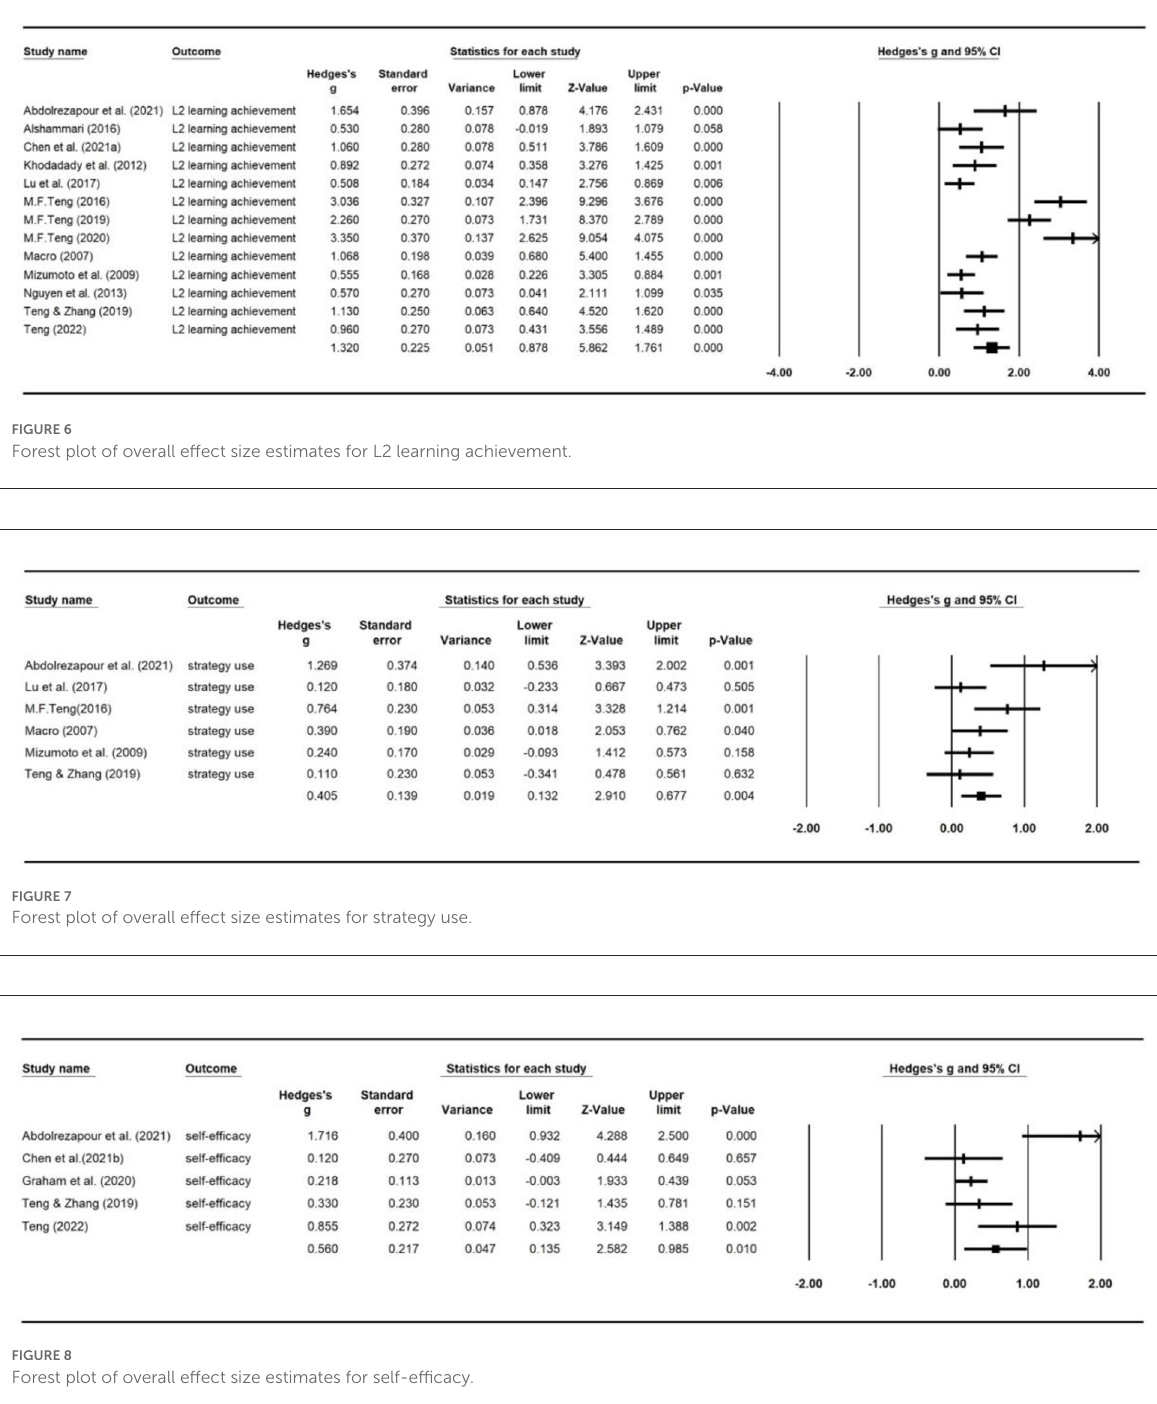
= 0.04). The results suggest that the instructional effects on all